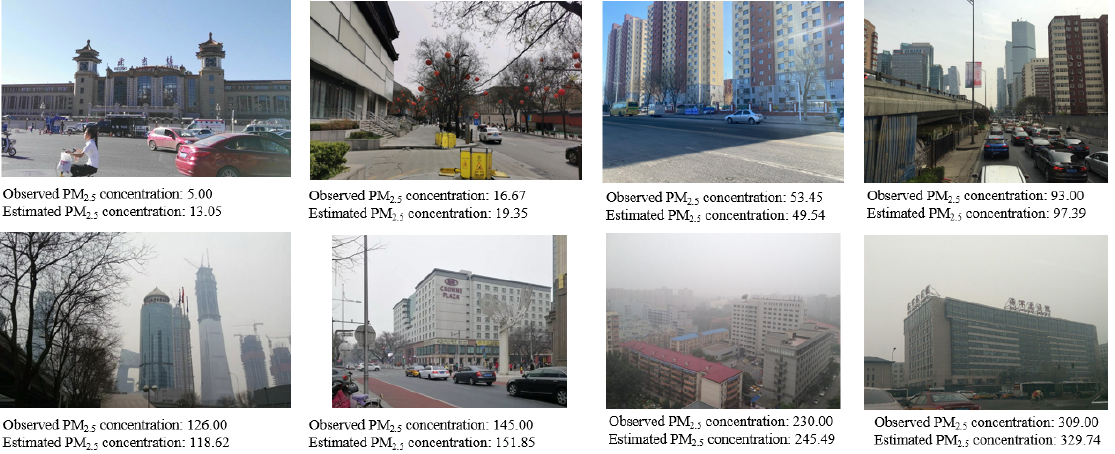
Figure 7. Examples of smartphone photographs with corresponding PM 2.5 concentrations measured at ground-based monitoring stations and PM 2.5 concentrations estimated by the MIFNN model.